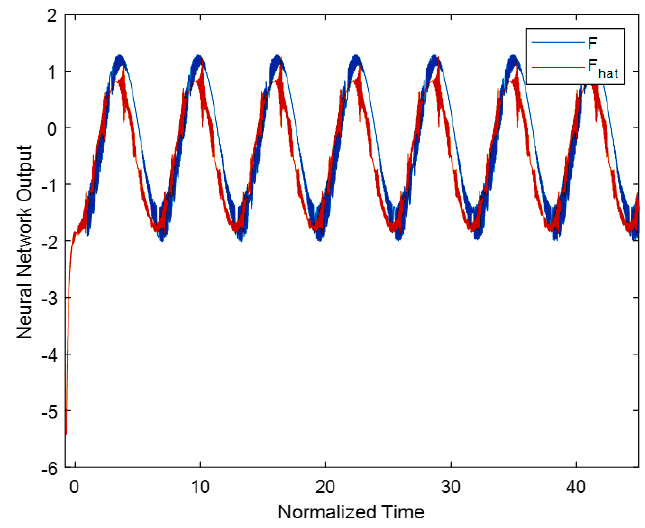
Figure 11. Output of the neural network for periodic input.